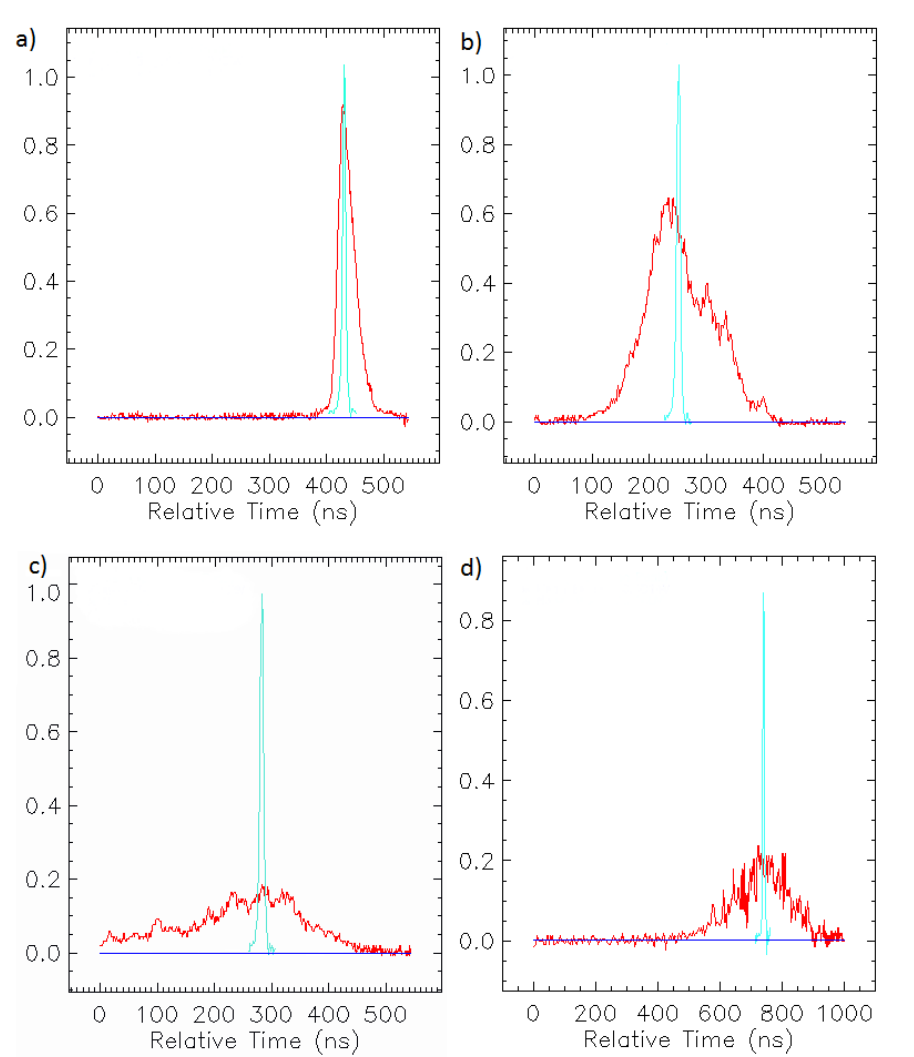
Figure 4. Waveforms of ICESat pulses recorded on 24 October 2003 over ( a ) flat glacier surface in A1 (slope = 1.7°), ( b ) steeper glacier surface (slope = 14.9°), ( c ) rough glacier surface marked by a number of crevasses that form between Ewig Schneefeld and Konkordiaplatz and ( d ) steep off-glacier slope south of Konkordiaplatz. The raw waveform is in red and the fit is in blue. One hundred ns corresponds to 15.1 m of the elevation difference. Positions of the points labeled as W1, W2, W3 and W4, respectively, are shown in Figure